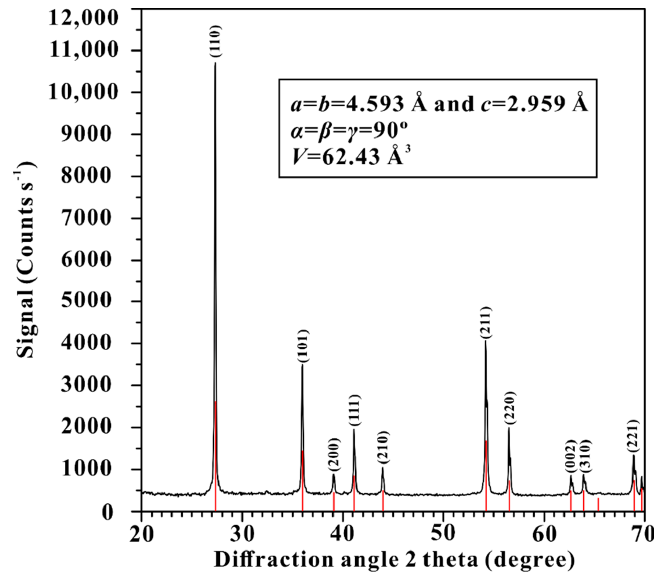
Figure 1. The X-ray diffraction (XRD) pattern of nanocrystalline rutile under ambient conditions.